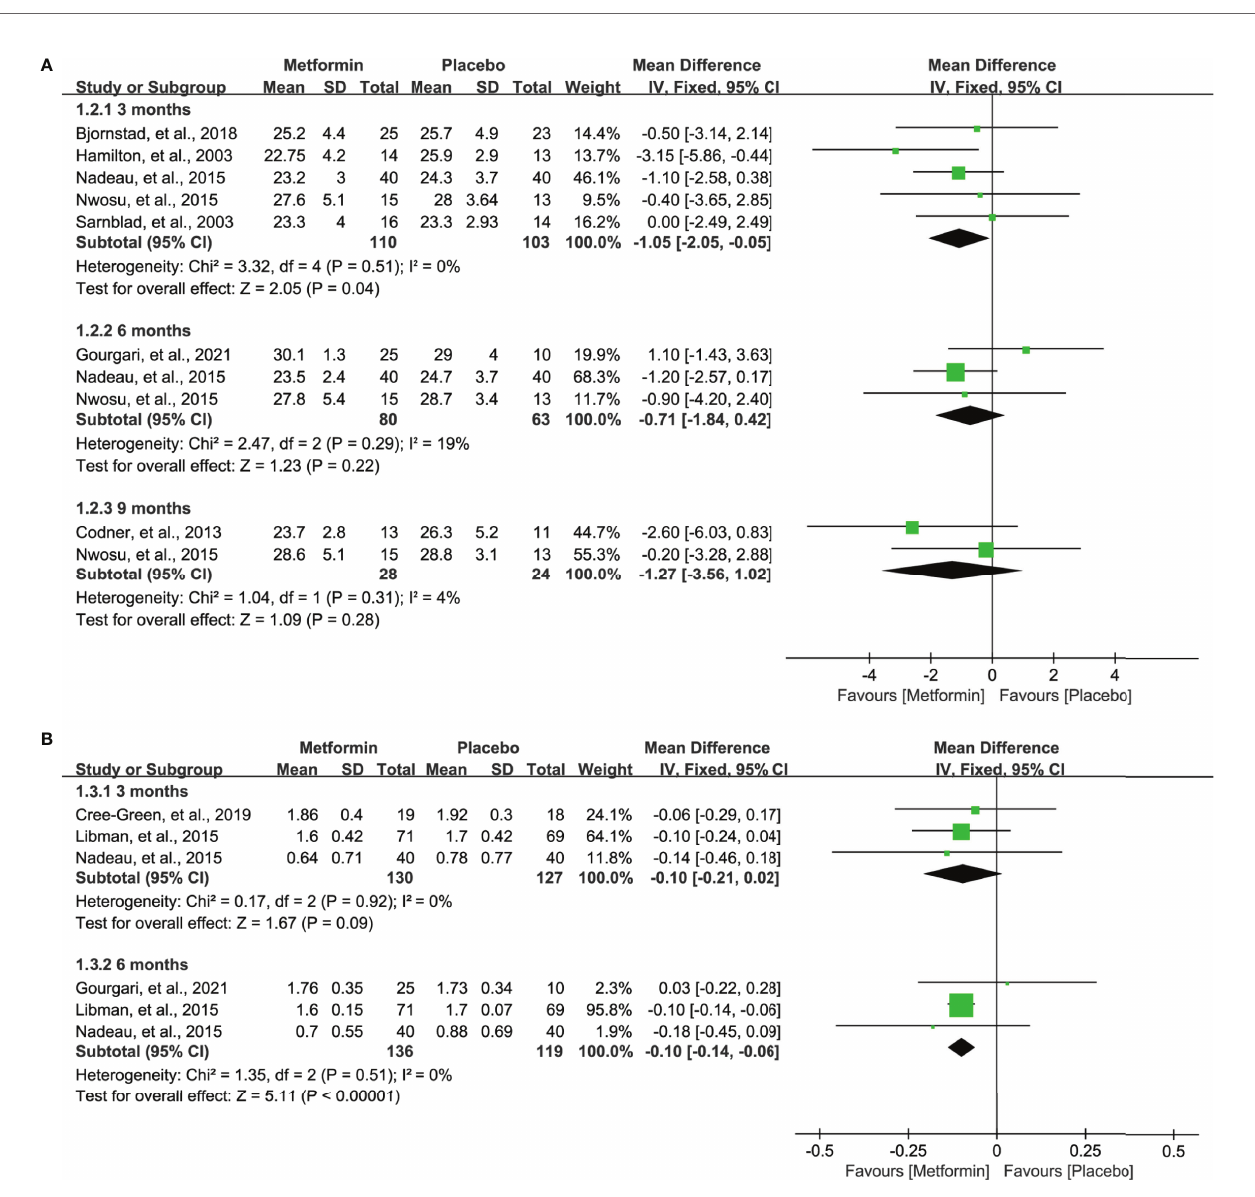
FIGURE 4 | Forest plot of the comparative ef fi cacy between metformin and placebo in terms of BMI at different follow-up duration. (A) BMI (kg/m 2 ) and (B) BMI